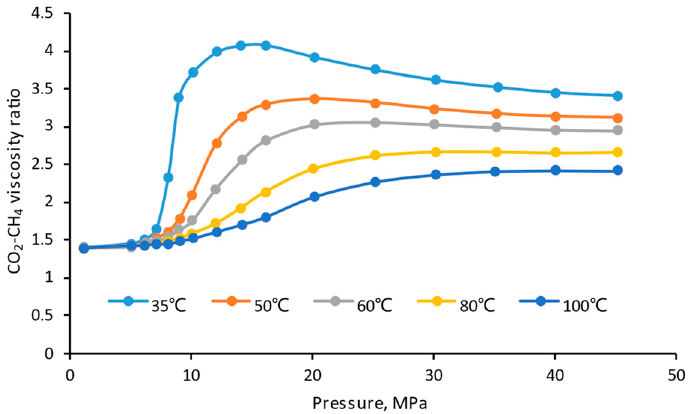
Figure 10. The CO 2 -CH 4 viscosity ratio variation curves under different temperatures and pressures.